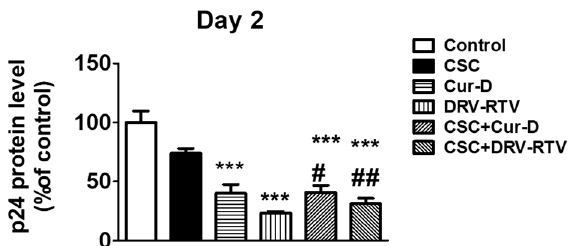
Figure 10. Effect of CSC and Cur-D on the viral load after crossing the in vitro human BBB model: To determine the efficacy of Cur-D on CSC-induced viral replication, we used differentiated U1 cells to create a modified in vitro human BBB model in a Transwell ® plate, as described in the methodology. The upper inserts containing endothelial cells were exposed to a single dose of Control (DMSO), CSC (40 µg/mL), Cur-D (0.4 µM), and DRV-RTV (12 µg/mL and 4 µg/mL, respectively) and observed for 2 days. HIV viral loads from U1 cells were measured every day, using a p24 ELISA kit from the culture media of the bottom chamber. One-way ANOVA with Tukey’s post-hoc test was applied to compare between multiple groups. *** represents p ≤ 0.001when compared to control. #, and ## represent p < 0.05, and p ≤ 0.01, respectively, when compared to CSC.